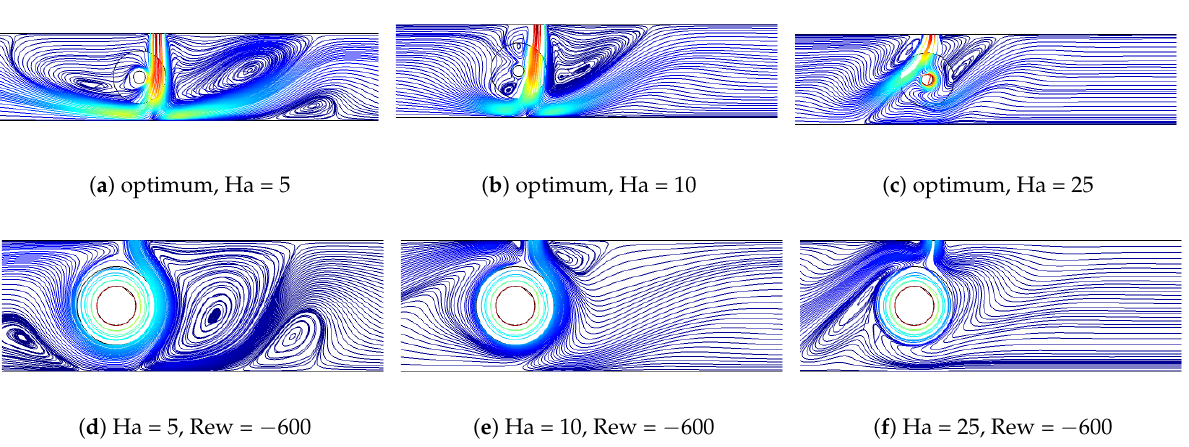
Figure 15. Streamline variations at optimal flow conditions ( a – c ) and with varying MaF strength at fixed values of (Da = 5 × 10 − 2 ,Mx = − 1,AR =